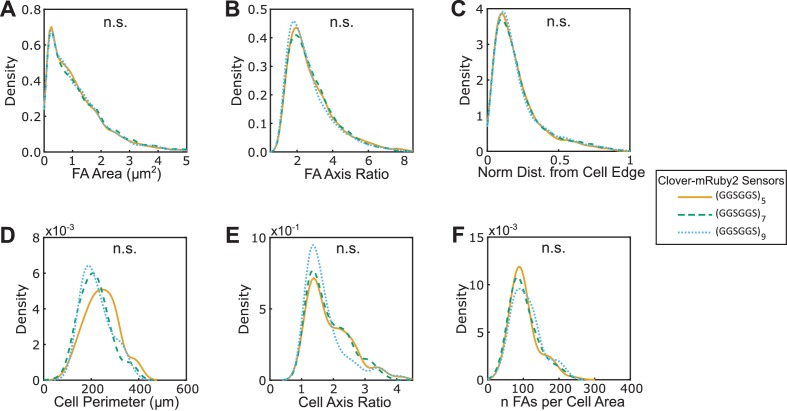
Three versions of VinTS-A50I exhibit similar FA morphologies, cell morphologies, and sensor localization to FAs.(A-F) Vin-/- MEFs expressing various version of VinTS-A50I show indistinguishable FA area (A), FA axis ratio (B), subcellular distributions of FAs quantified as normalized distance from cell edge (C), cell perimeter (D), cell axis ratio (E), number of FAs normalized by cell area (F). Different versions of the tension sensor were constructed with minimal Clover-mRuby2 modules flanking three distinct extensible domains, namely (GGSGGS)5 (n = 60 cells), (GGSGGS)7 (n = 58 cells), (GGSGGS)9 (n = 62 cells), pooled from three independent experiments; n.s. not significant (p≥0.05), ANOVA. See Supplementary file 4 for exact p-values.